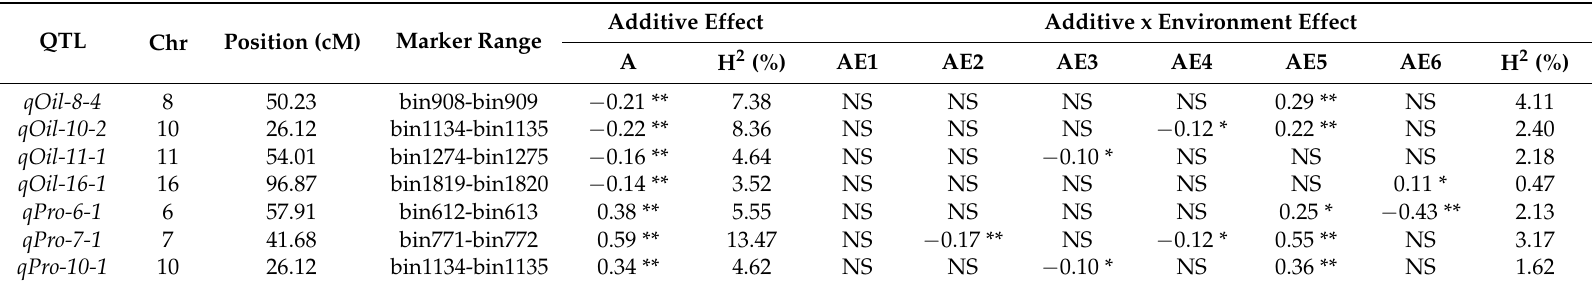
Table 3. Additive and additive × environment interaction effect of QTLs associated with protein and oil contents in soybean seed.